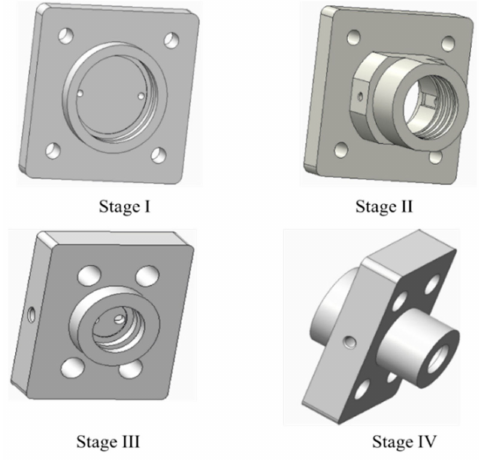
Figure 5. 3D model of the stress analysis for the cylinder.